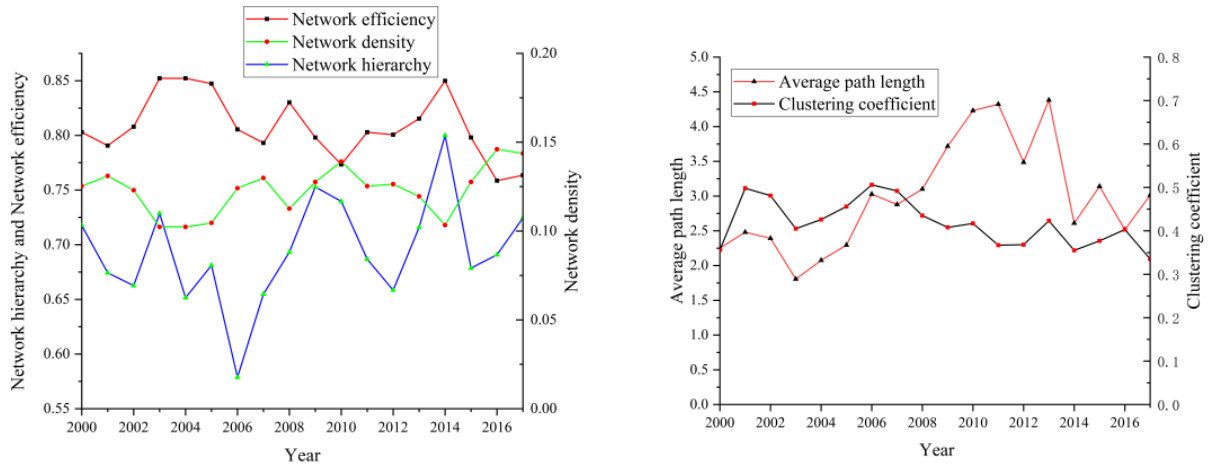
Figure 3. Overall spatial network structure of tourism eco-efficiency.